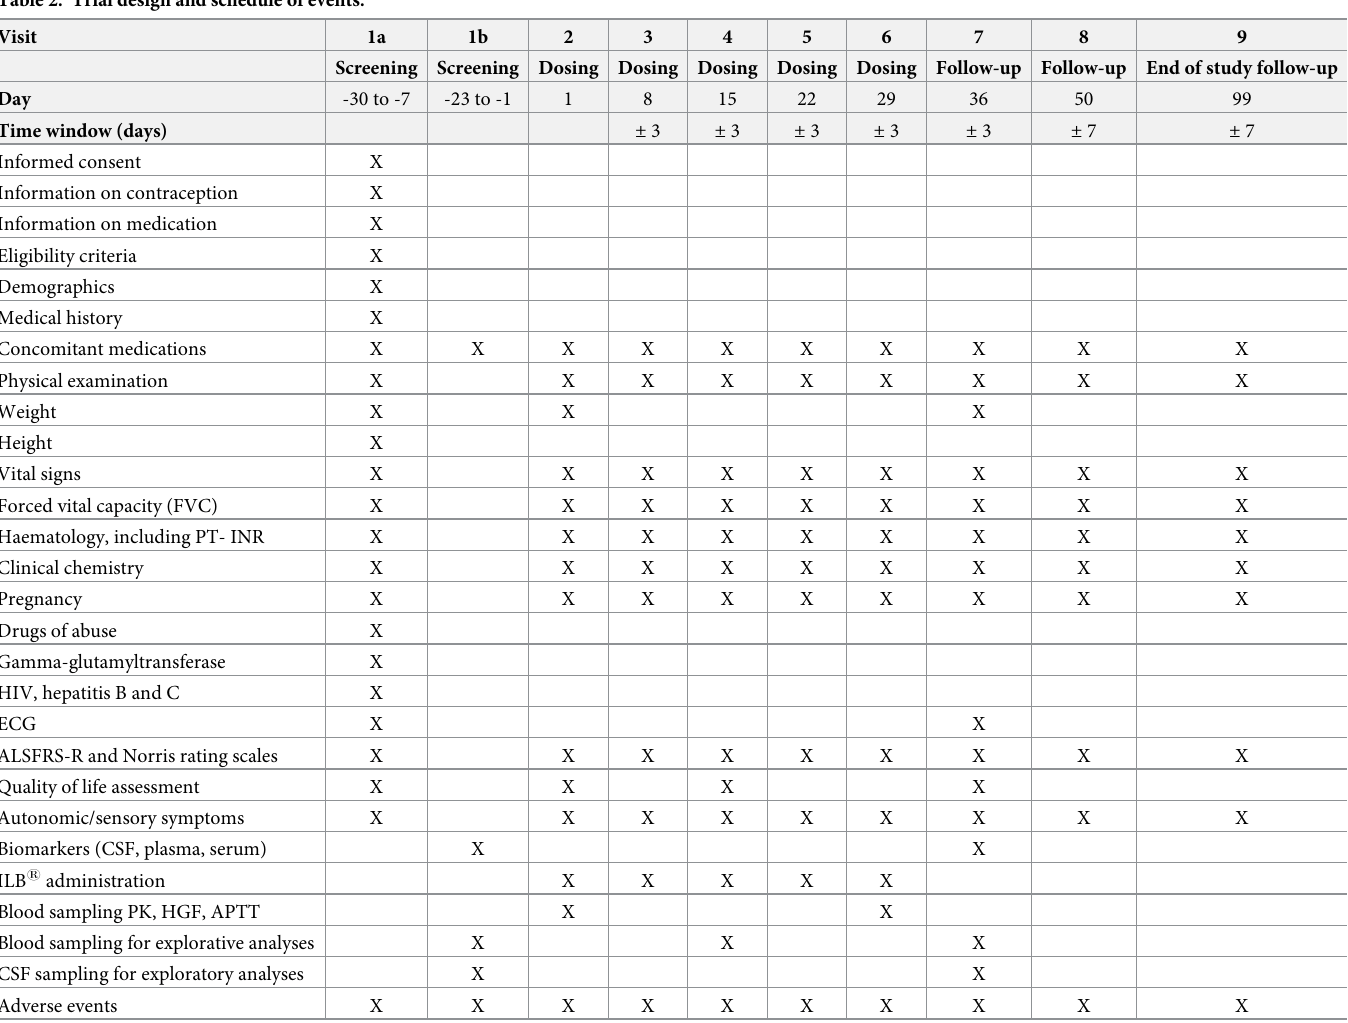
Table 2. Trial design and schedule of